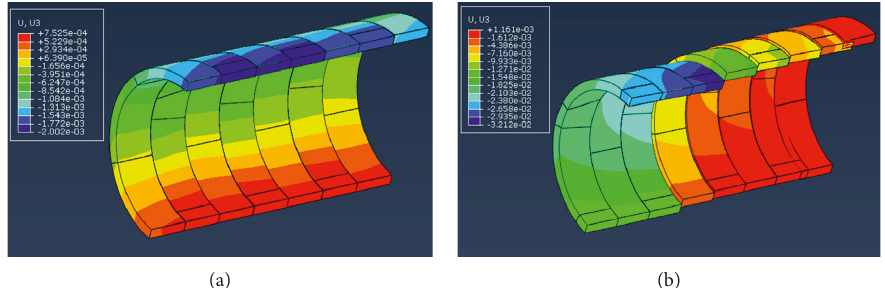
Figure 10: The segment deformation under different water drains. (a) No draining at the excavation face. (b) Fully drained at the excavation face.